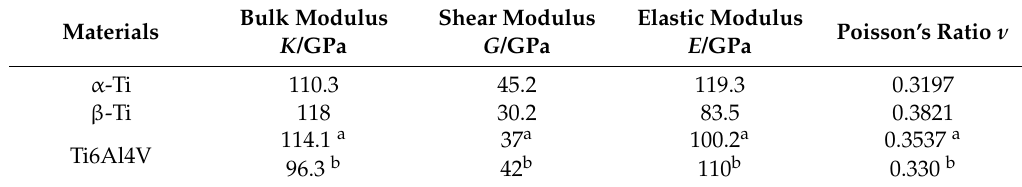
Table 3. The mechanical elastic constants of materials used in calculation.